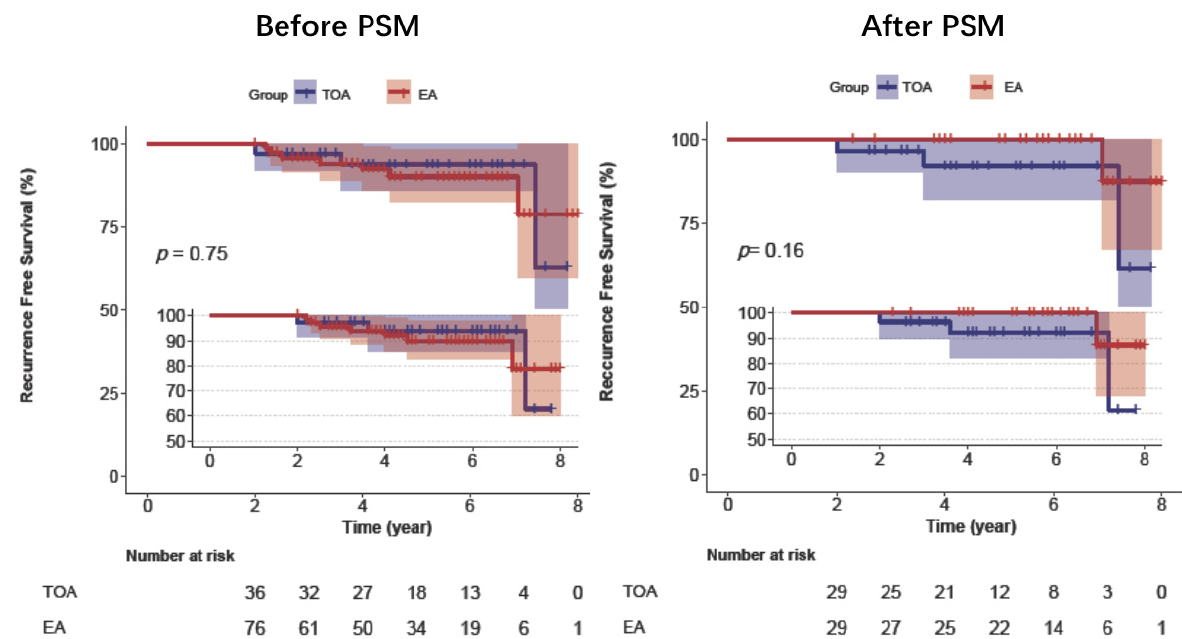
Figure 1. Kaplan–Meier analysis of recurrence-free survival of patients in the transoral approach and external approach groups before and after PSM. Abbreviations : TOA, transoral approach; EA, external approach; PSM, propensity score matching.